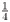
Sensitivity of β(t) estimation error to data-generating parameters other than 〈β〉 and α.Plotted in each panel is the median RRMSE (Eq (33)) in estimates of a seasonally forced β(t) (Eq (27)) from simulated reported incidence time series (Δt = 1 week, n = 1042), as a univariate function of each of 5 or 6 data-generating parameters (indicated by the legend). When simulating reported incidence, reference values (Table 1) were assigned to all but the focal parameter, which was assigned 41 values logarithmically spaced between 14 and 4 times its reference value. The horizontal axis (logarithmic scale) measures the ratio of the focal parameter’s true value to its reference value, so that commensurate deviations from the reference case can be compared across parameters. For each parametrization, 1000 simulations were performed with environmental stochasticity [ES] (ϵ = 0.5) and with or without demographic stochasticity [DS] and observation error [OE], as indicated by row: [Row A] without DS or OE (prep = 1, trep = 0 weeks), [Row B] with DS but without OE (prep = 1, trep = 0 weeks), or [Row C] with DS and OE (prep = 0.25 except when prep is the focal parameter, trep = 2 weeks). Corresponding mock birth and natural mortality time series were created, then β(t) was estimated from the data using [Left] the S method and [Right] the SI method, all without input error. For each set of estimates of β(t) (1000 estimates per parametrization, per simulation method, per estimation method), the median RRMSE was calculated (after smoothing with fixed q; see Eq (59)) and displayed as one point in the appropriate panel and graph.